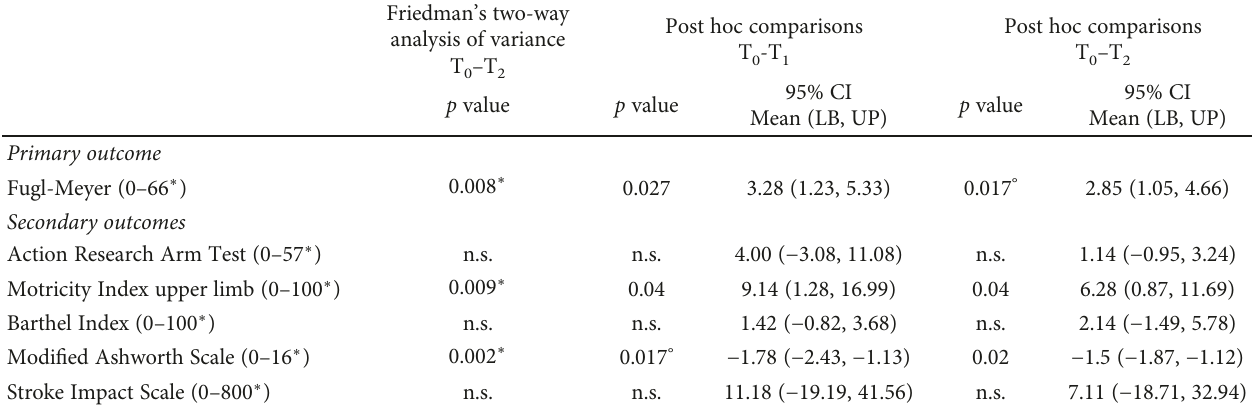
Table 3: Within-group training e ff ects on clinical outcome